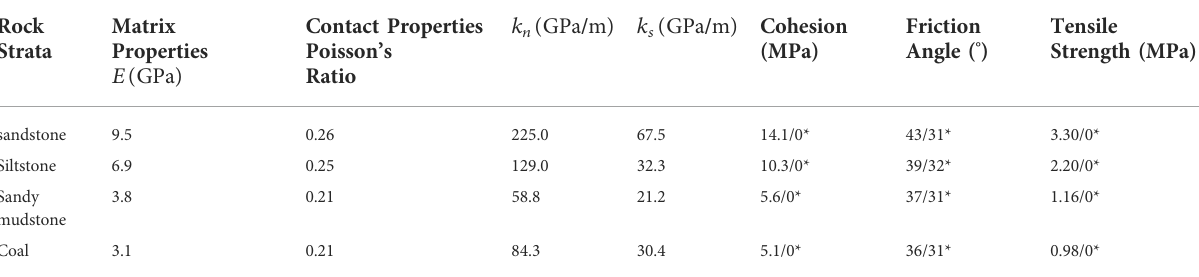
TABLE 2 Calibrated micro-properties for UDEC-Trigon